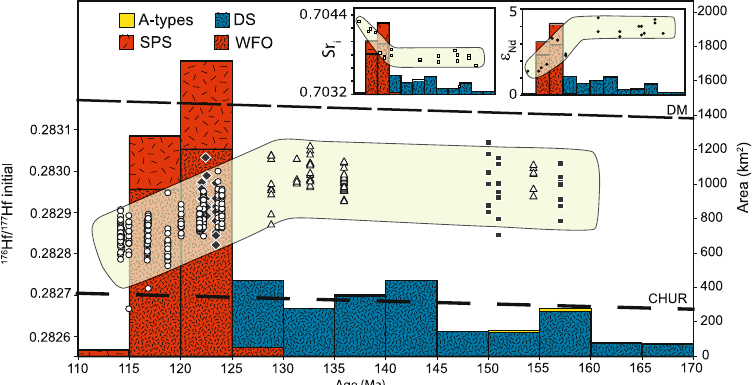
Figure 4. Hfi evolution over time for the three main Mesozoic plutonic suites of Fiordland combined with the flux rates (km 2 ) over time. The excursion to evolved compositions is concomitant with the flare-up, attesting to the crustal component in these magmas. Circles: Western Fiordland Orthogneiss 28 , diamonds: Separation Point Suite and Western Fiordland Orthogneiss 24 ), Triangles: this study, squares 29 . Inset of Sr i and ε Nd 27, 32, 33